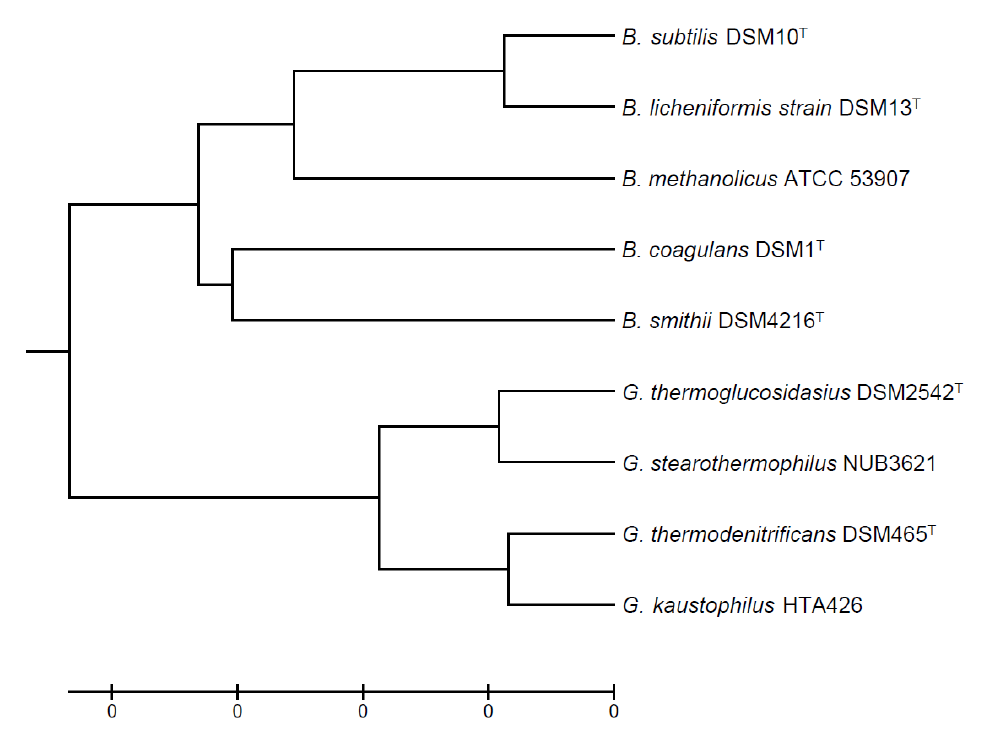
Figure 1. Evolutionary relationships of thermophilic Bacillaceae using B. subtilis as a reference strain. The evolutionary history was inferred using the UPGMA method [32]. The optimal tree with the sum of branch length = 0.22091755 is shown. The tree is drawn to scale, with branch lengths in the same units as those of the evolutionary distances used to infer the phylogenetic tree. The evolutionary distances were computed using the Maximum Composite Likelihood method [33] and are in the units of the number of base substitutions per site. The analysis involved 9 nucleotide sequences. All positions containing gaps and missing data were eliminated. There were a total of 1387 positions in the final dataset. Evolutionary analyses were conducted in MEGA7 [34].